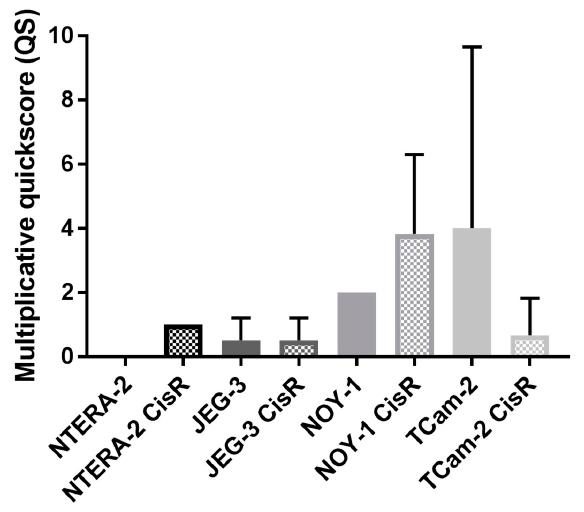
Figure 3. AIF expression in different GCTs cell lines in xenograft model.